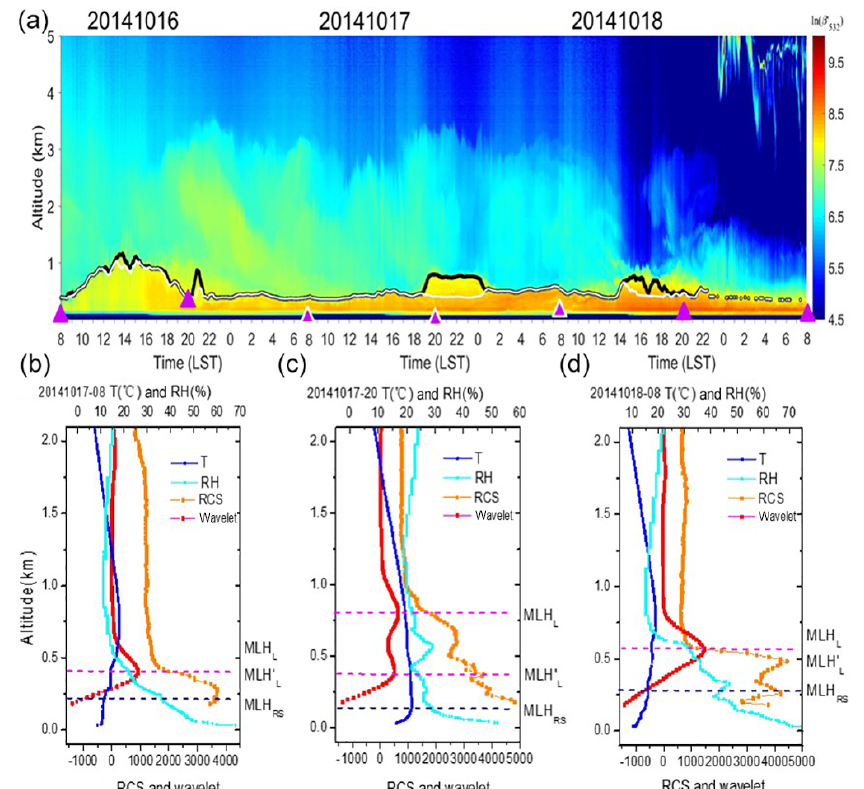
Figure 4. Similar to Fig. 1, but for (a) 16–18 October 2014, and with vertical profiles for (b) 08:00 LST on 17 October 2014, (c) 20:00 LST on 17 October 2014 and (d) 08:00LST on 18 October